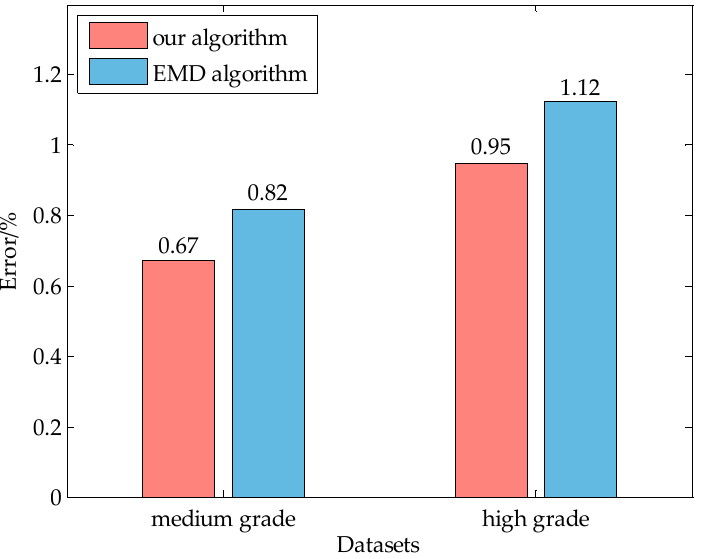
Figure 11. Comparison of the average error rate between the proposed algorithm and EMD algorithm.